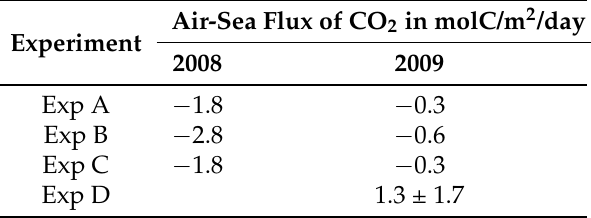
Table 2. Air-sea flux annual integrated values for each of the